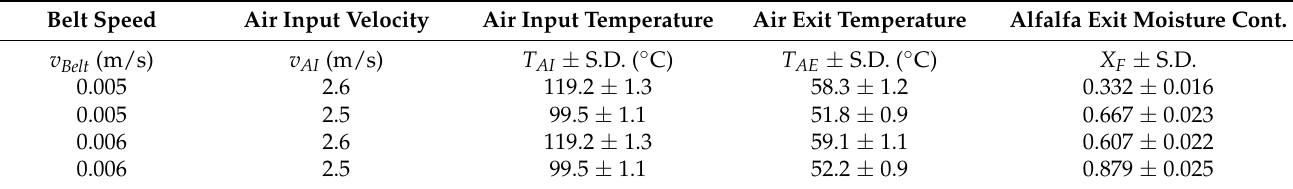
Table 2. Experimental data of the pilot dryer.